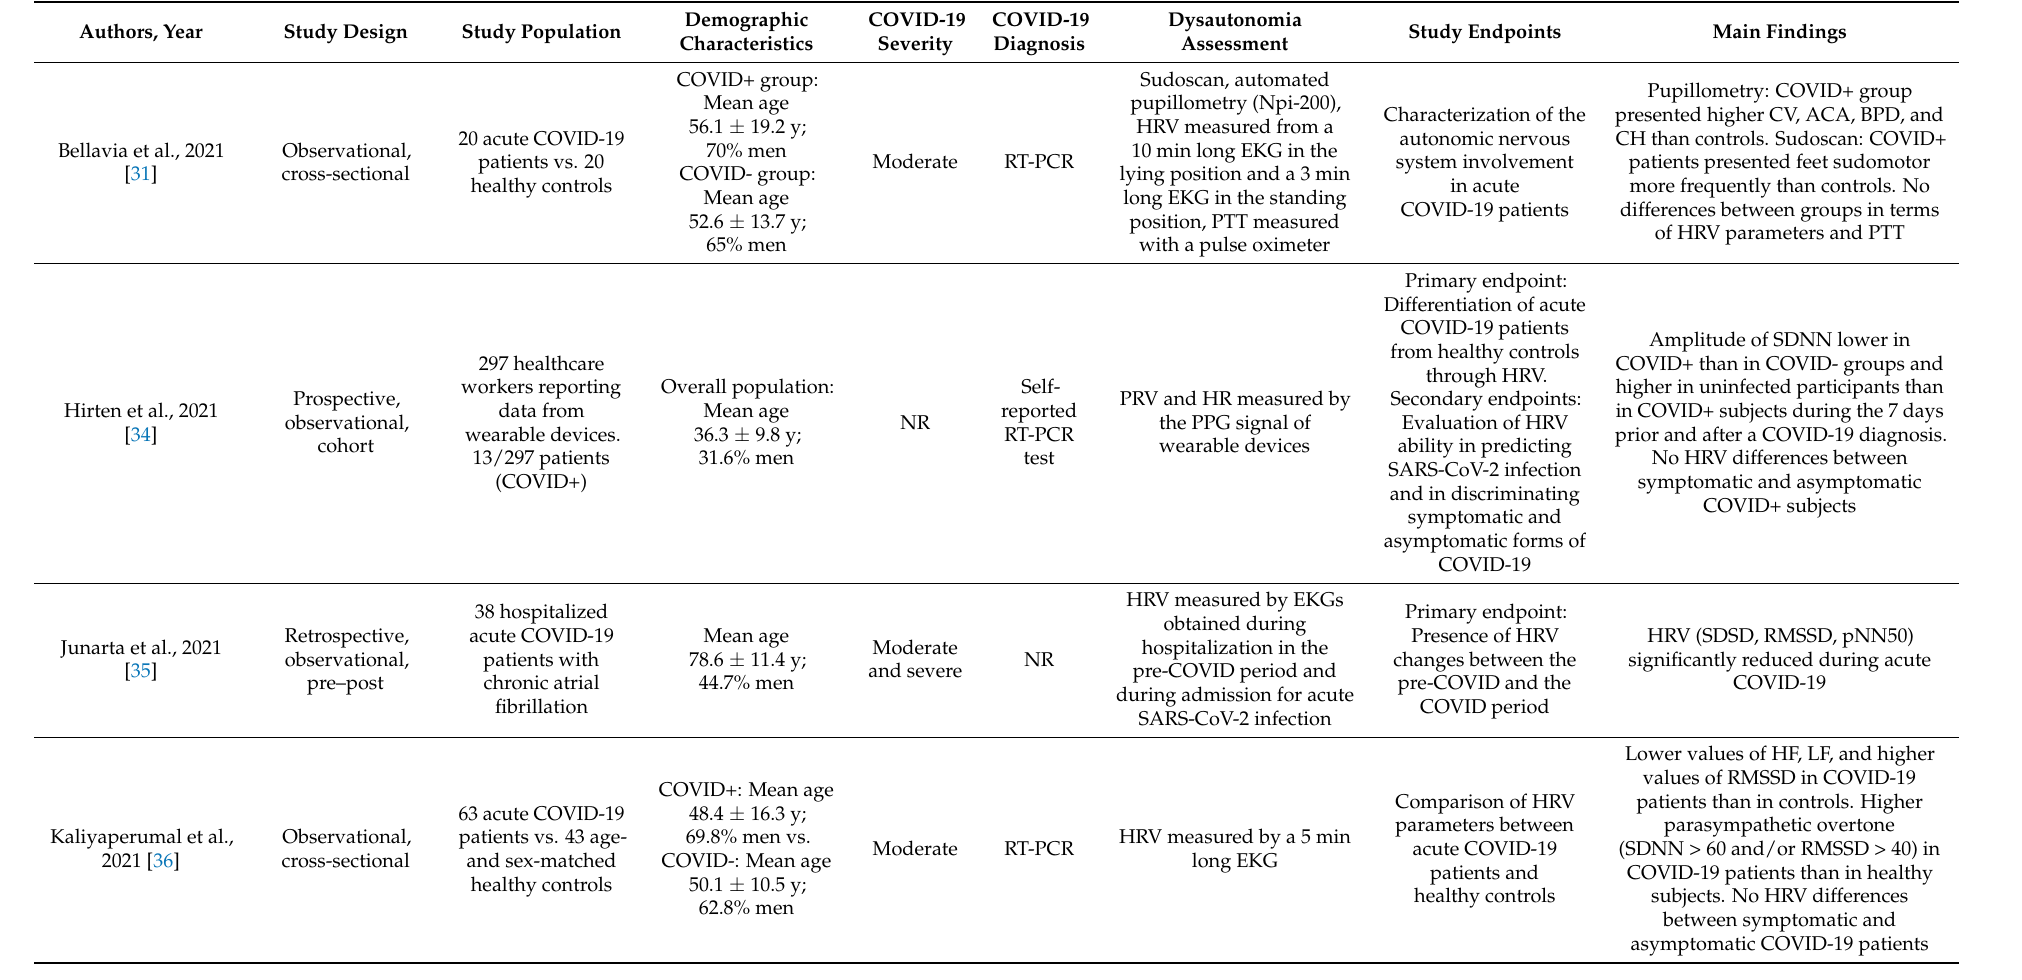
Table 2. A summary of the data extracted from the 13 studies, which characterized acute COVID-19-related autonomic